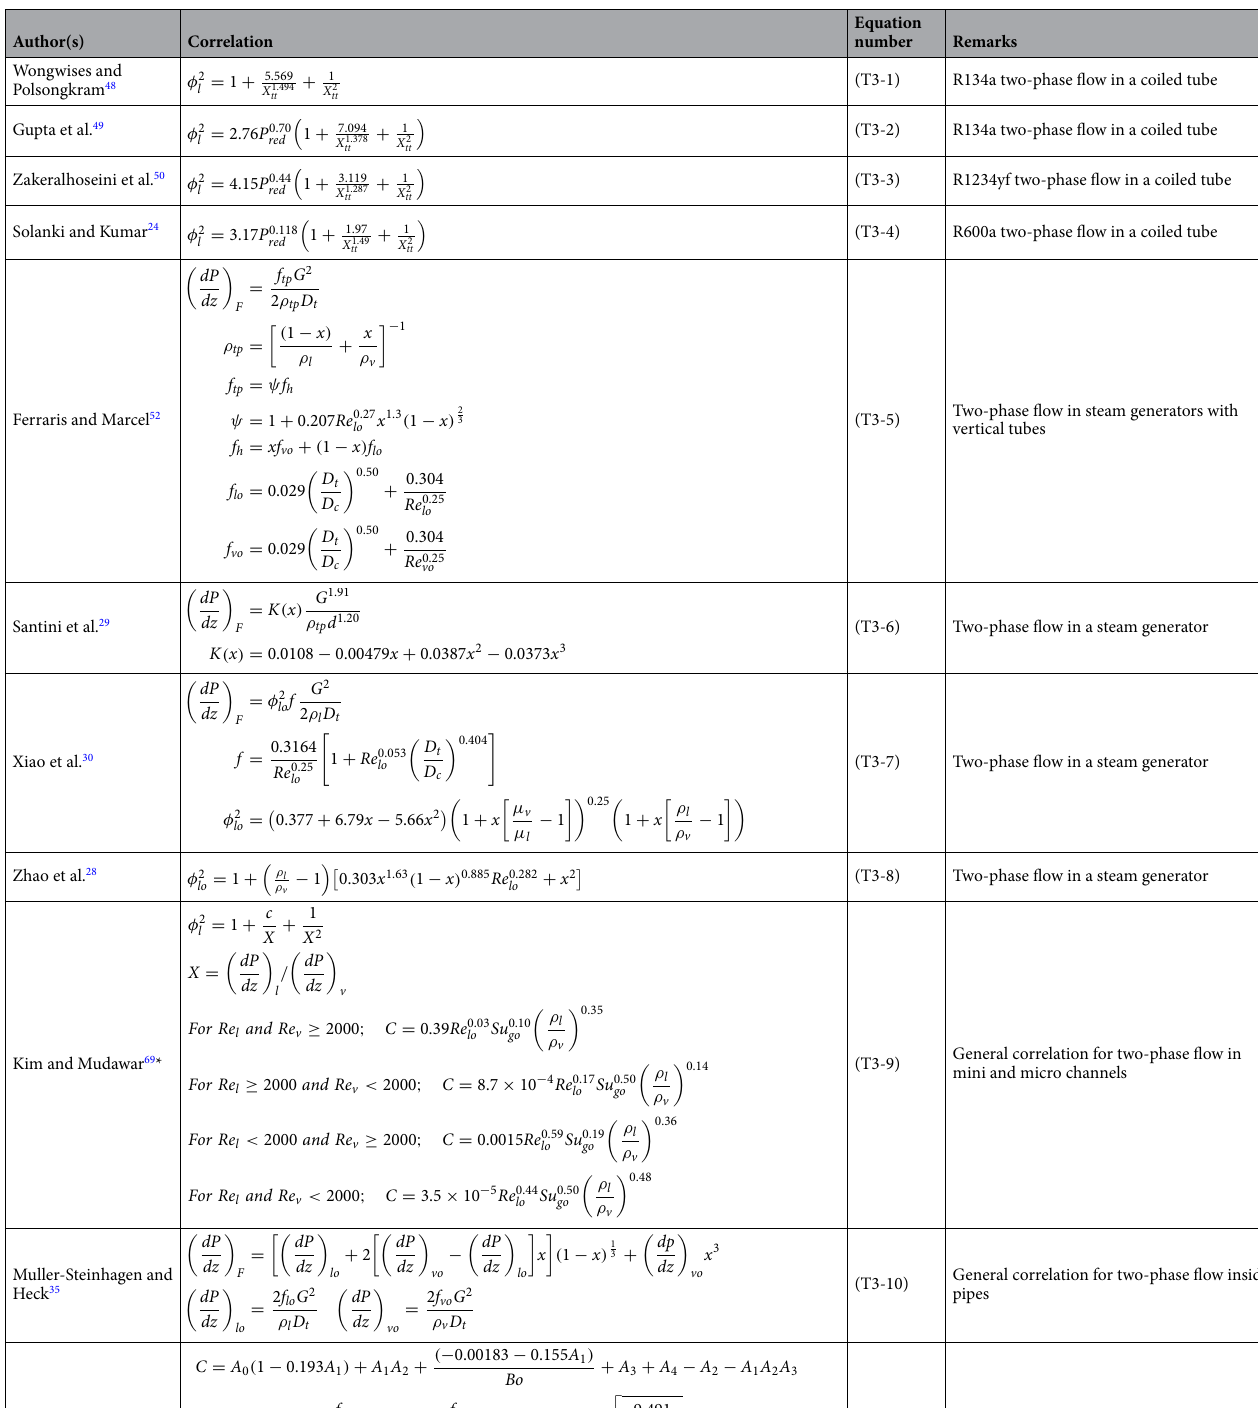
Table 3. Previous models for estimating the FPD in coiled and straight tubes. *Marked authors used the Chisholm 70 method for calculating the φ